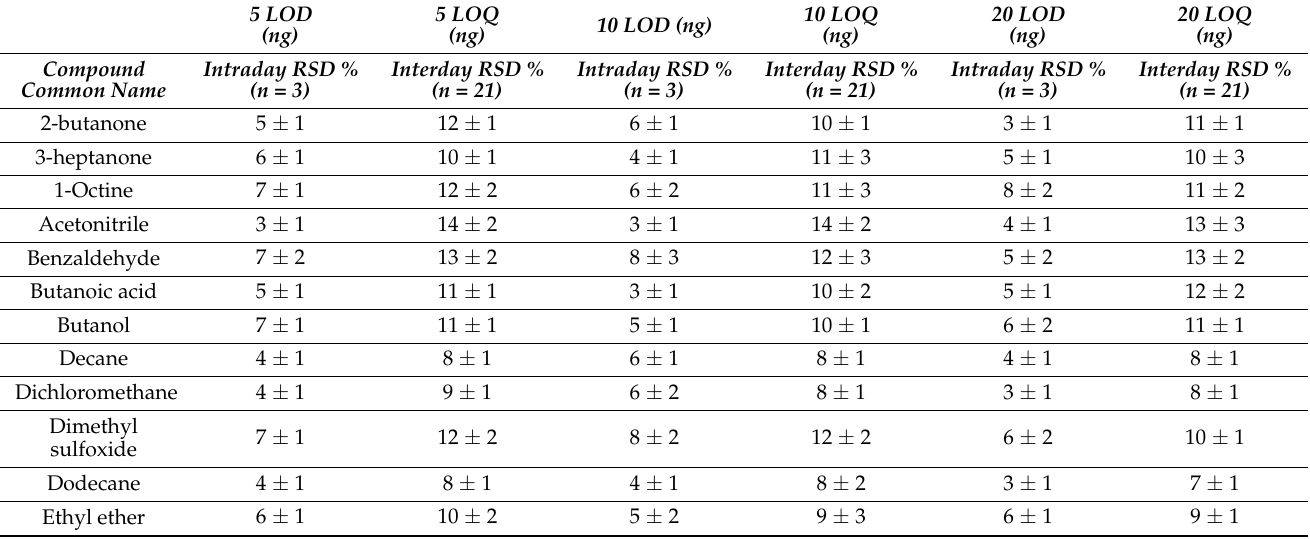
Table 5. Intraday and interday mean RSD % values for selected